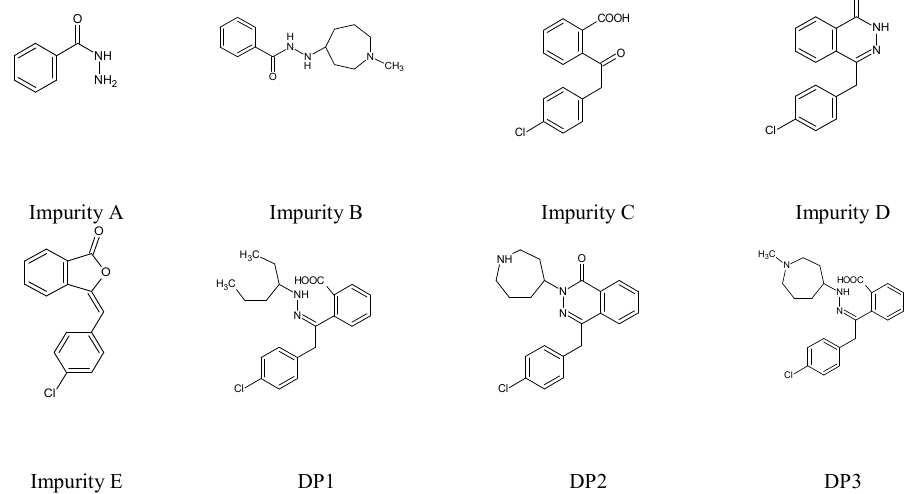
Figure 3. Chemical structures of the related substances of azelastine (AZE) [18,20,22].